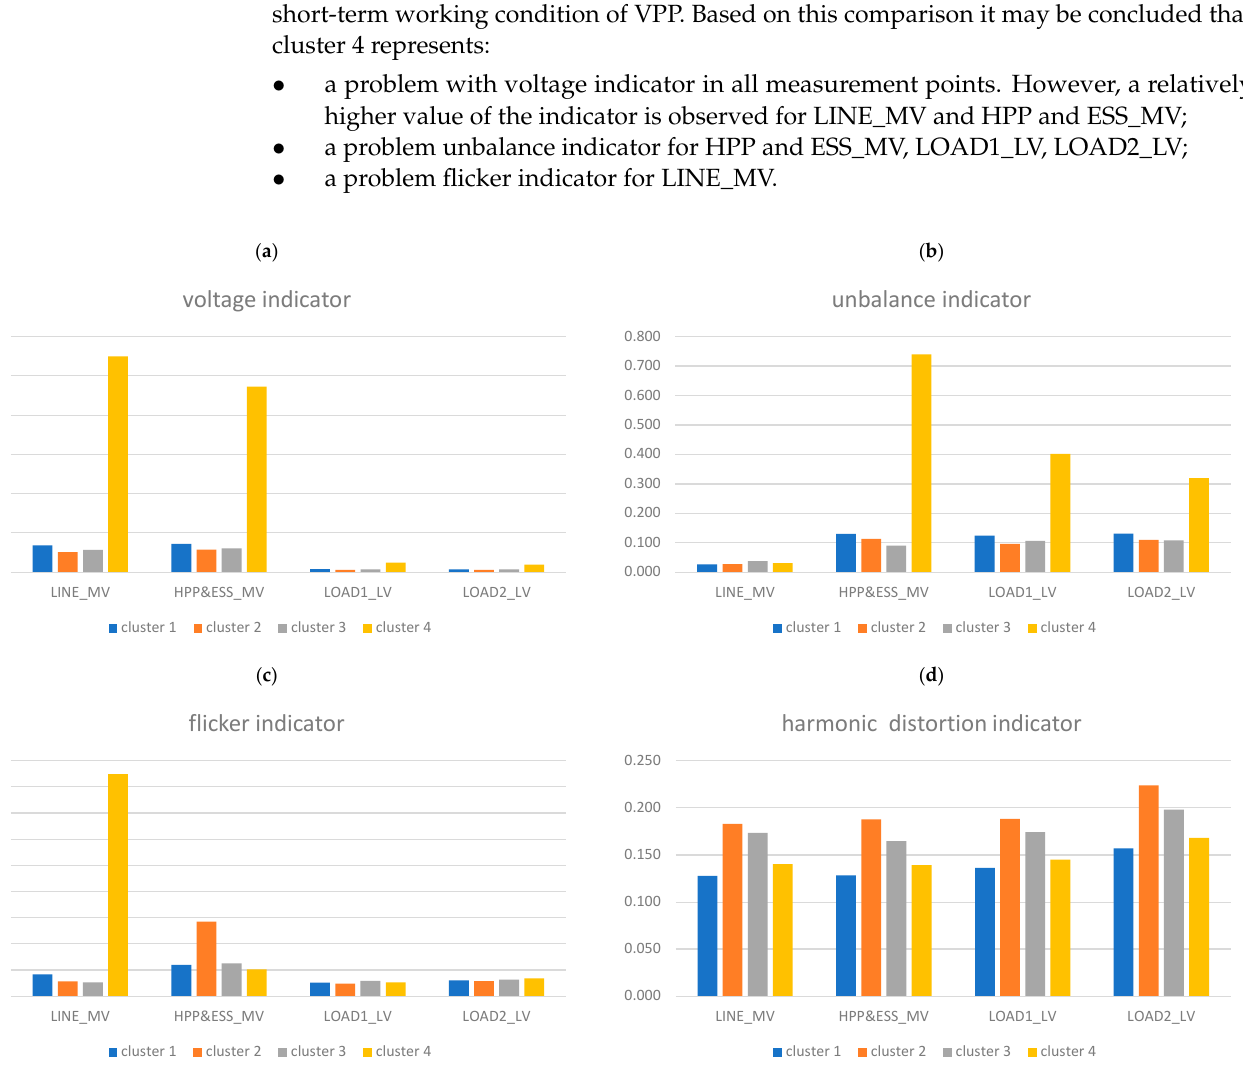
Figure 6. The qualitative comparison between clusters for power quality pollution index (PQPI) indicators: ( a ) voltage indicator; ( b ) unbalance indicator; ( c ) flicker indicator; ( d ) harmonic distortion indicator.